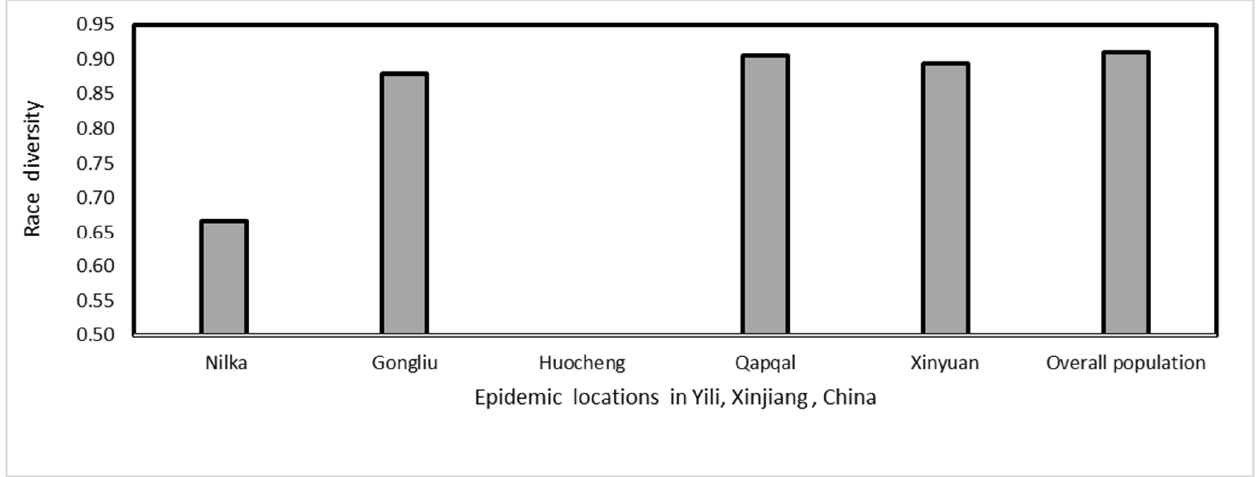
Figure 3. Race diversity in Puccinia striiformis f. sp. tritici isolates collected from Yili, Xinjiang, China, in 2021. Table 4. Frequencies (%) of di ff erent races detected from Puccinia striiformis f. sp . tritici isolates col- lected from di ff erent locations in Xinjiang province of China in 2021.